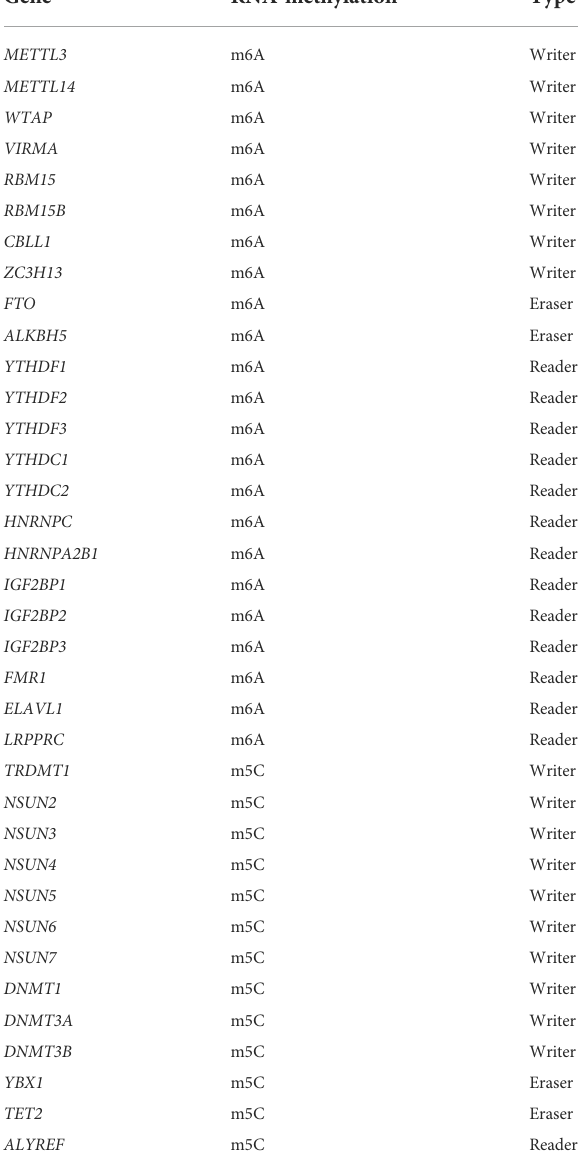
TABLE 1 Genes related with m6A and